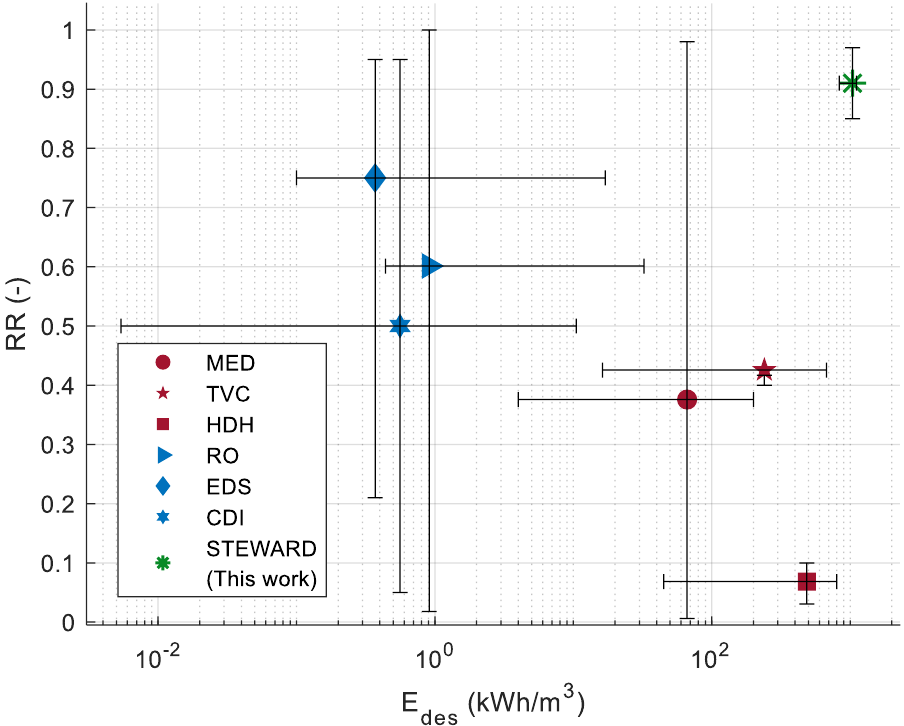
Figure 6. Operational map for different desalination technologies.